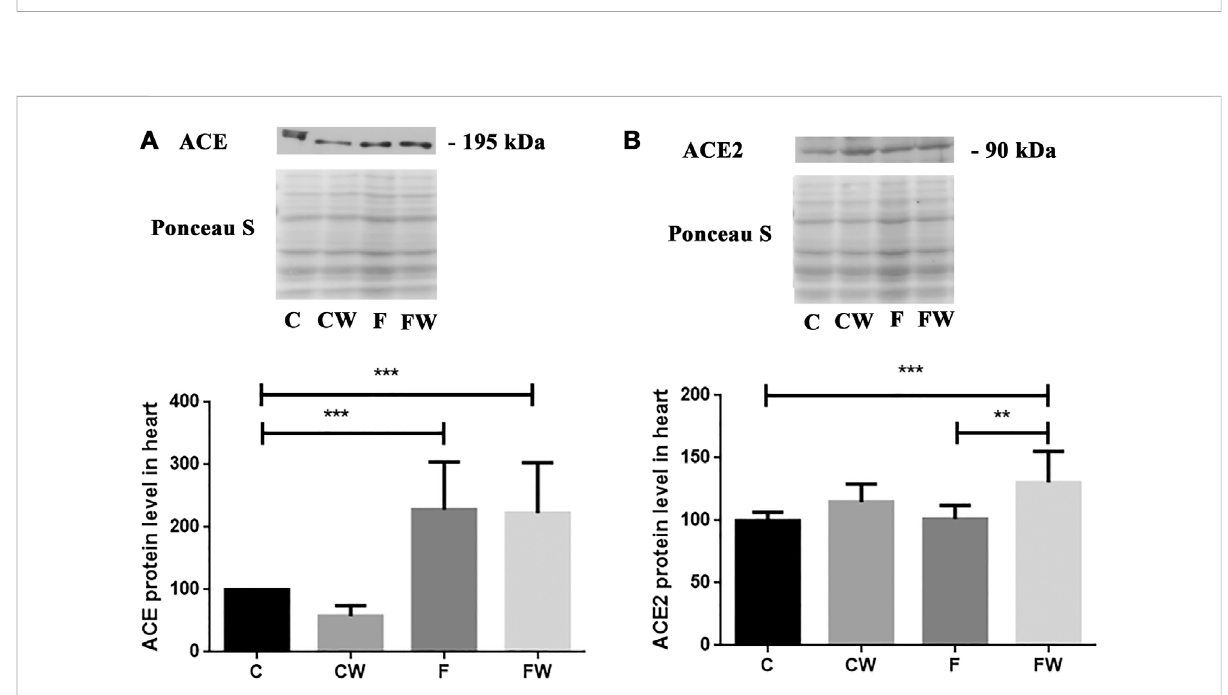
FIGURE 2 Effects of fructose-rich diet and walnut supplementation on (A) ACE and (B) ACE2 protein level in heart of experimental rats. Values are means with standard deviations represented by vertical bars for 3 samples, each consisting of 3 pooled hearts of the same group. C — animals on